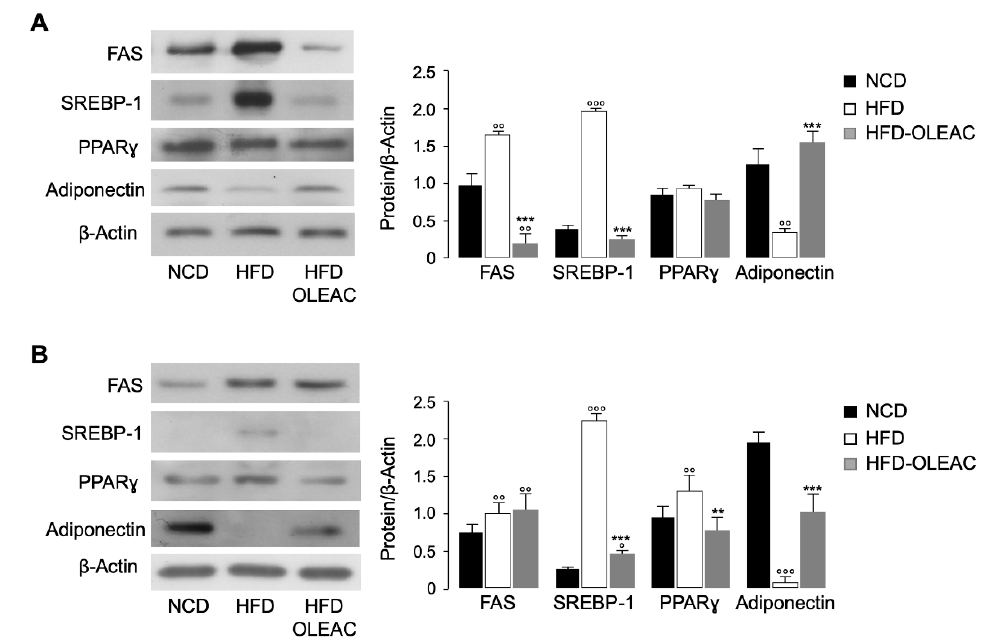
Figure 2. Effects of oleacein on adipogenesis-related markers. Representative Western blots of abdominal fat protein from mice of the first ( A ) and second ( B ) set of experiments. β -Actin, control of protein loading. Densitometric analysis of proteins on Western blots is shown in bar graphs, in each condition. Values are expressed as means ± SD from three experiments performed with four mice from each group. ◦ p < 0.05, ◦◦ p < 0.01, ◦◦◦ p < 0.001 vs. NCD; ** p < 0.01, *** p < 0.001 vs. HFD. NCD, normal caloric diet; HFD, high fat diet; HFD-OLEAC, high fat diet-oleacein.FAS, fatty acid synthase.; SREBP-1, sterol regulatory element-binding transcription factor-1, PPAR γ , peroxisome proliferator-activated receptor gamma.